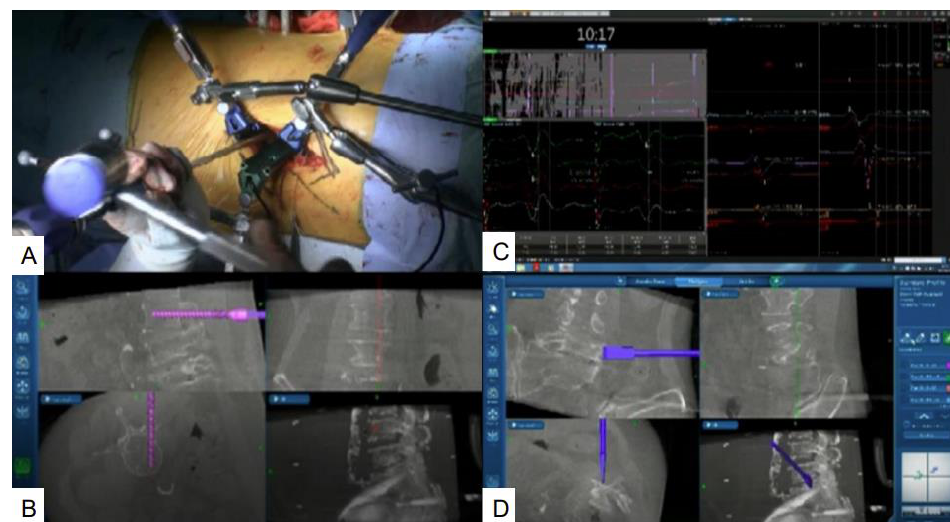
Figure 7. Simultaneous PPS and navigated osteotome. ( A ) Surgical field; ( B ) Simultaneous PPS; ( C ) Neuromonitoring; ( D ) Navigated osteotome.